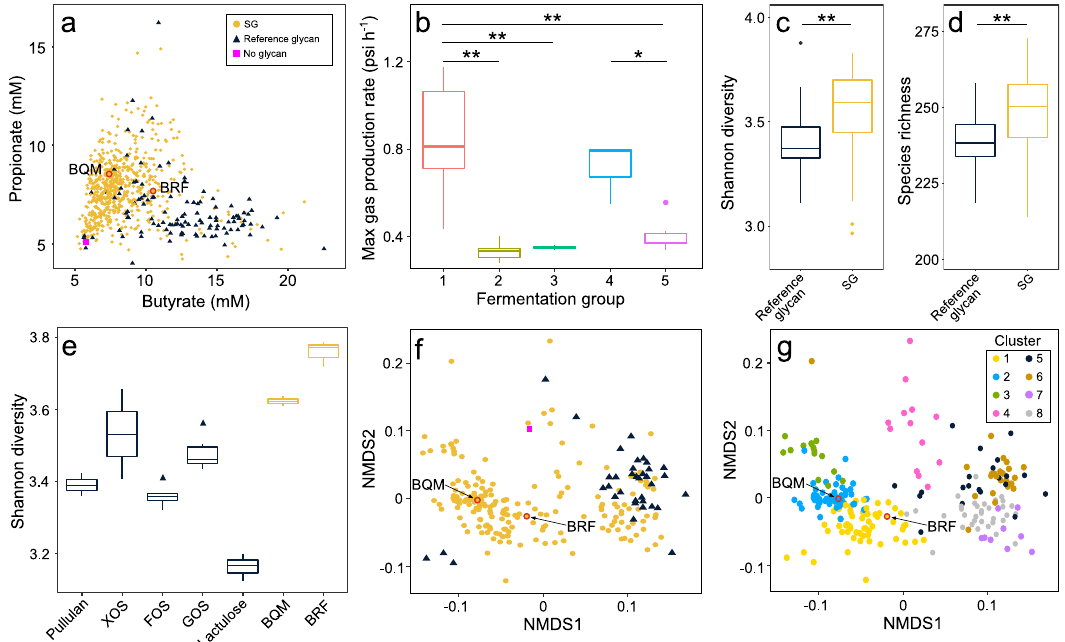
Fig. 2 Effects of glycans on fecal community metabolic output and taxonomic composition. a Yields of two SCFAs, butyrate and propionate, from fecal cultures fermenting either an SG (yellow circles, n = 653), reference glycan (indigo triangles, n = 110), or no glycan (magenta square). b Maximum gas production rate (psi h − 1 ) during fecal culture fermentation of glycans from each of the fi ve fermentation groups in Fig. 1e – g. c Shannon diversity and d species richness of fecal cultures fermenting SGs (yellow, n = 190) versus reference glycans (indigo, n = 40). e Shannon diversity of fecal cultures fermenting BRF or BQM (yellow) is higher than reference glycans (indigo) for all comparisons except BQM versus XOS (Kruskal – Wallis followed by Dunn ’ s comparison test, p < 0.05). f NMDS of metagenomic data calculated based on a matrix of Bray – Curtis dissimilarities using species-level mapping of sequencing reads from fecal cultures grown on either an SG (yellow circles, n = 190), reference glycan (indigo triangles, n = 40), or no glycan (magenta square). g NMDS as in f colored by differences in taxonomic composition de fi ned by eight K-means clusters based on species-level mapping of sequencing reads. Data for each glycan is the mean of ( a – d , f , g ) three or ( e ) six replicate fecal cultures grown on 5 g l − 1 of each SG or reference glycan for 45 h in MM29 medium. a , f , g BRF and BQM highlighted in red. b – e Box plots show median and interquartile ranges. Asterisks show signi fi cance (* p <